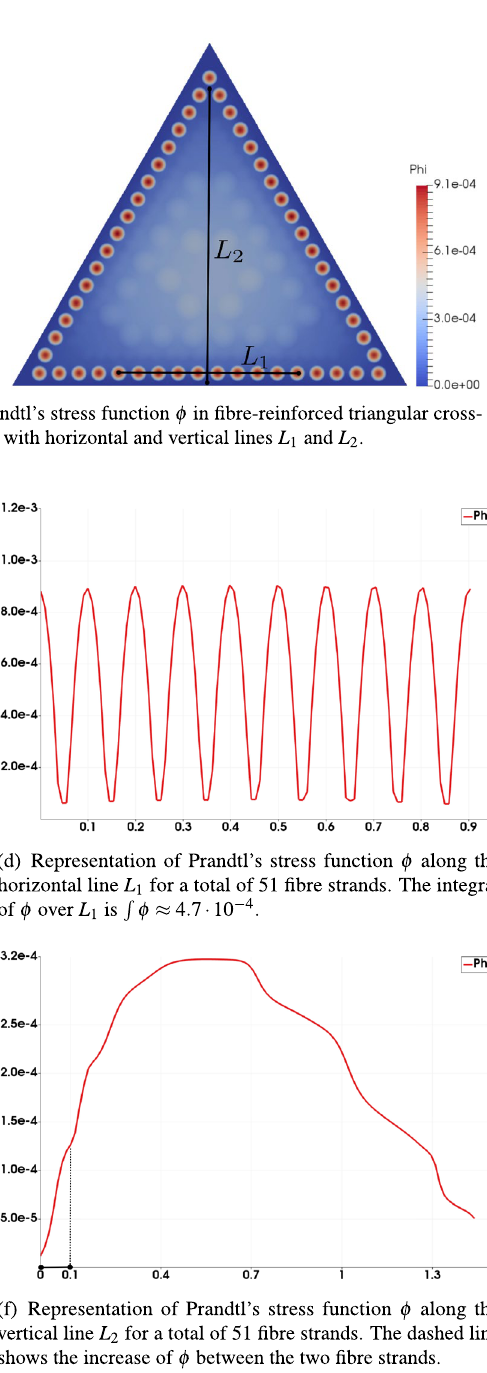
Figure 6. Local representation of Prandtl’s stress function. For different numbers of fibre strands, the stress function φ is plotted along horizontal and vertical lines, L 1 and L 2 , in ( b ) and thereby two opposing effects are illustrated. By increasing the number of fibre strands but by fixing their total area, φ decreases within the number of fibre strands, see ( c ) and ( d ), but increases in the inner part of the cross-section, see ( e ) and ( f ). This because, as the distance between the fibre strands becomes smaller, the gradient of φ between two fibre strands is increased and, therefore, the value of φ in the inner part of the cross-section is raised. This effect becomes dominant from a certain number of fibre strands and, thus, increases the torsional rigidity. Further, the impact of these effects on the torsional rigidity depends on the ratio µ between the elastic moduli of the two mechanically decisive materials. For high ratios µ , the impact of the effect in ( e ) and ( f ) is more pronounced, whereas for low ratios, the impact of the effect in ( c ) and ( d ) is more intense. The fineness of the triangulation is sufficiently high, so that even small gaps between fibre strands can be resolved, see ( a